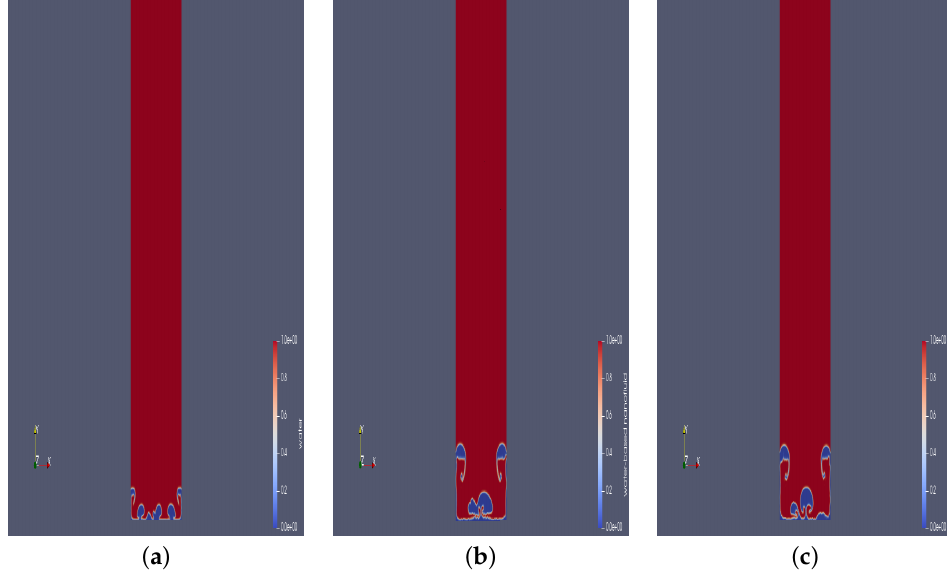
Figure 12. Snapshot of solutions for multi-phase mixtures at time t = 7.5 s. ( a ) Water. ( b ) Water-Al 2 O 3 nanofluid. ( c ) Water-TiO 2 nanofluid.